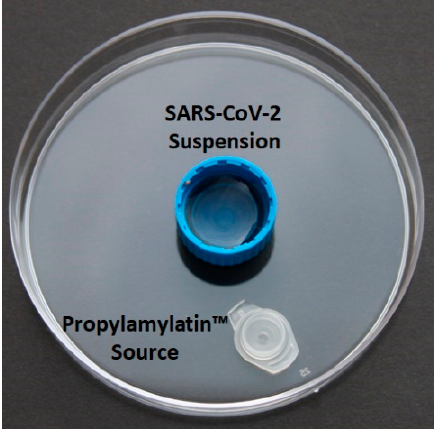
Figure 1. Layout for the vapor evaluations of the Propylamylatin formula against SARS-CoV-2. The blue plastic cap in the center holds 1 mL of SARS-CoV-2 diluted to 10 5 PFU/mL in MEM. The white cap holds 100 µls of the Propylamylatin formula or PBS and is placed 2.5 cm away from the center cap. The petri dish was rimmed with parafilm to prevent gas from escaping the environment. Two experimental plates and two control plates were harvested at each time